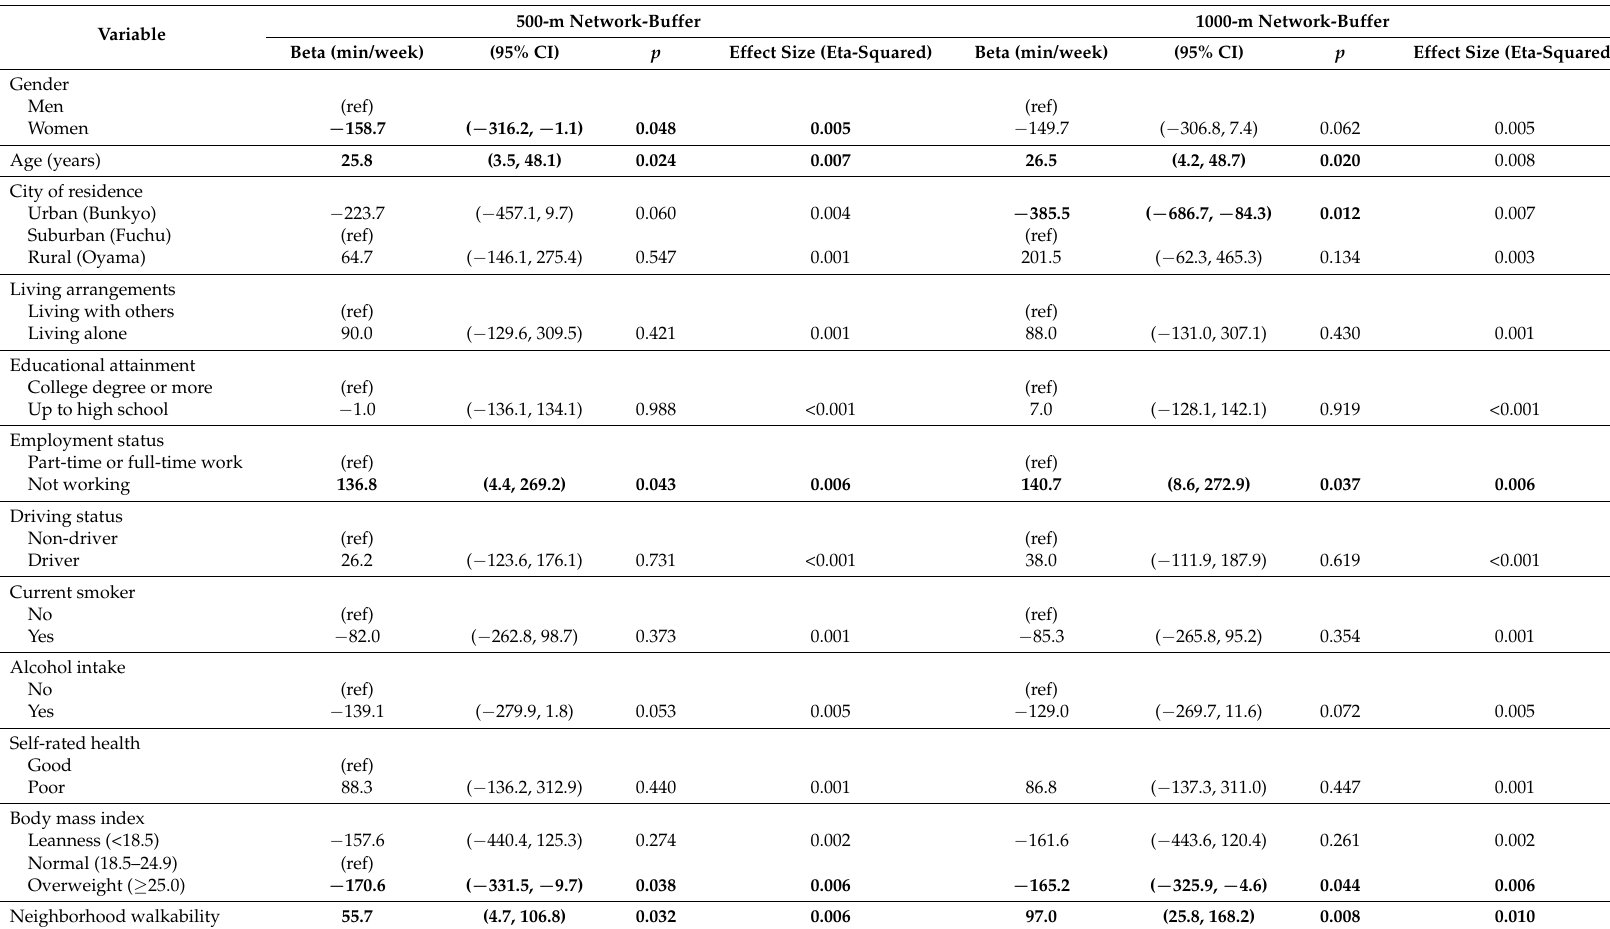
Table 2. Association between change of total MVPA in the 5-year period and neighborhood walkability/socio-economic status: Multivariate regression analyses.